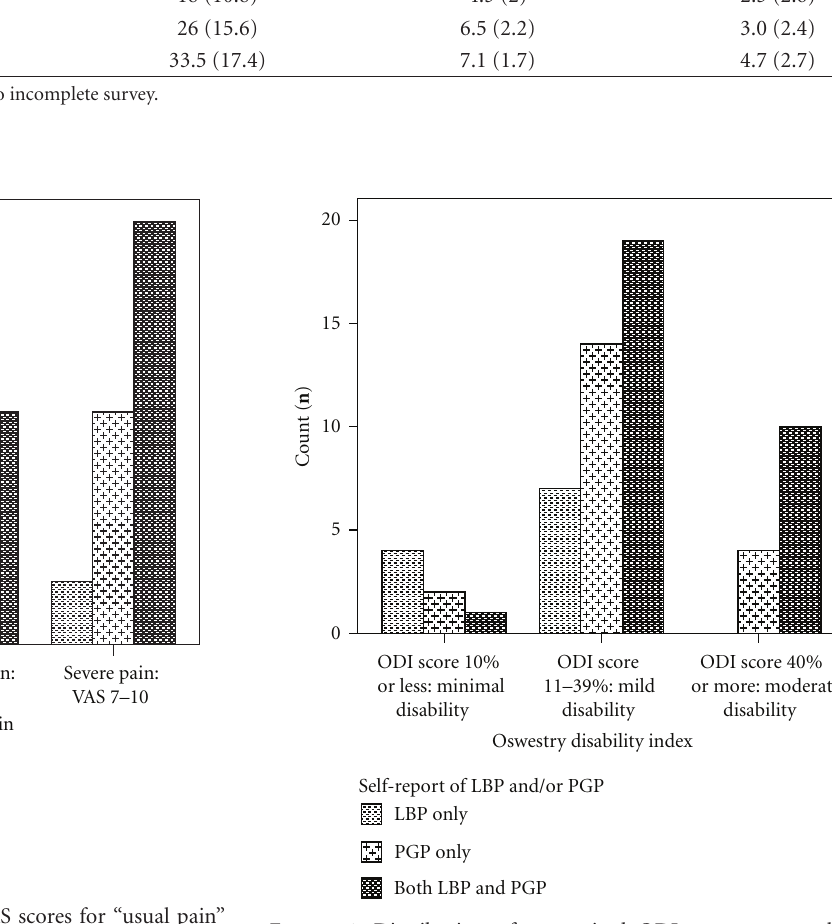
Figure 4: Distribution of categorised ODI scores across the 3 categories: LBP, PGP, and both LBP and